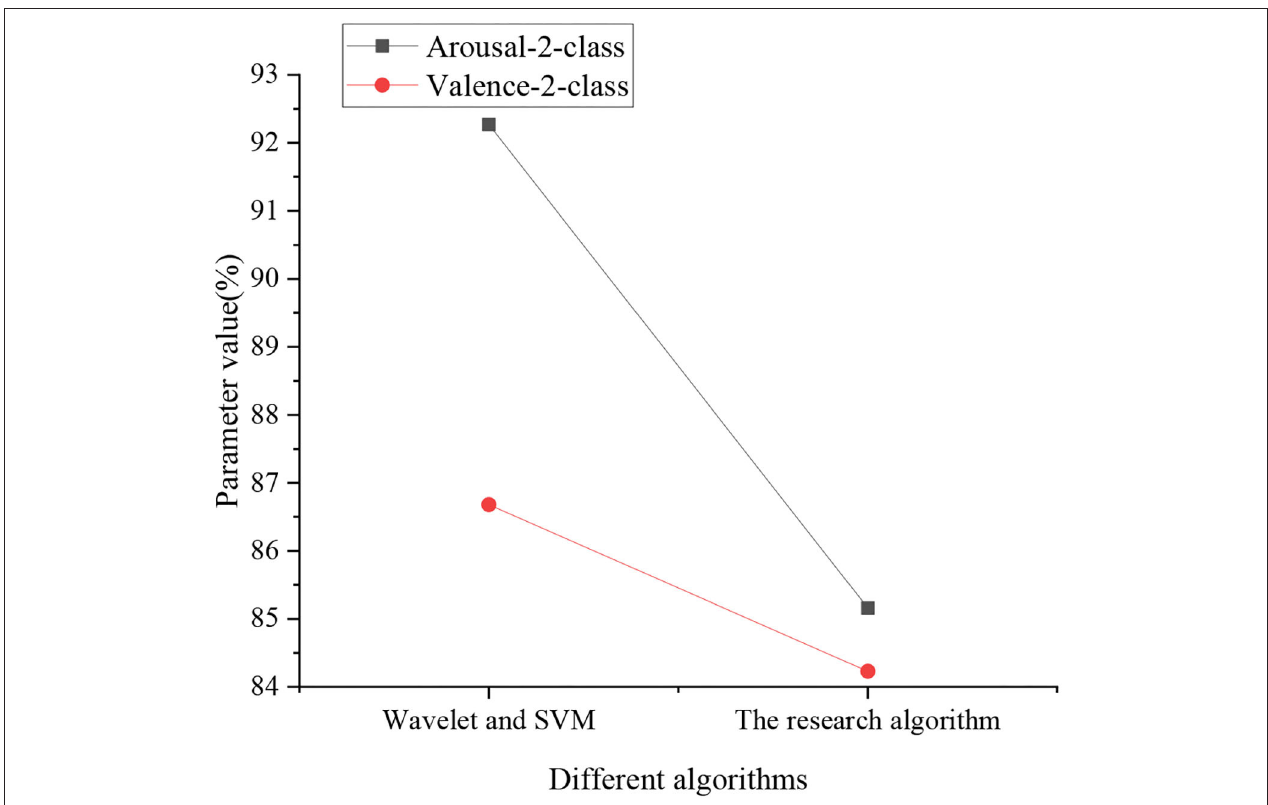
FIGURE 10 | Comparison of Wavelet and SVM with the CNN-based deep Q-Learning